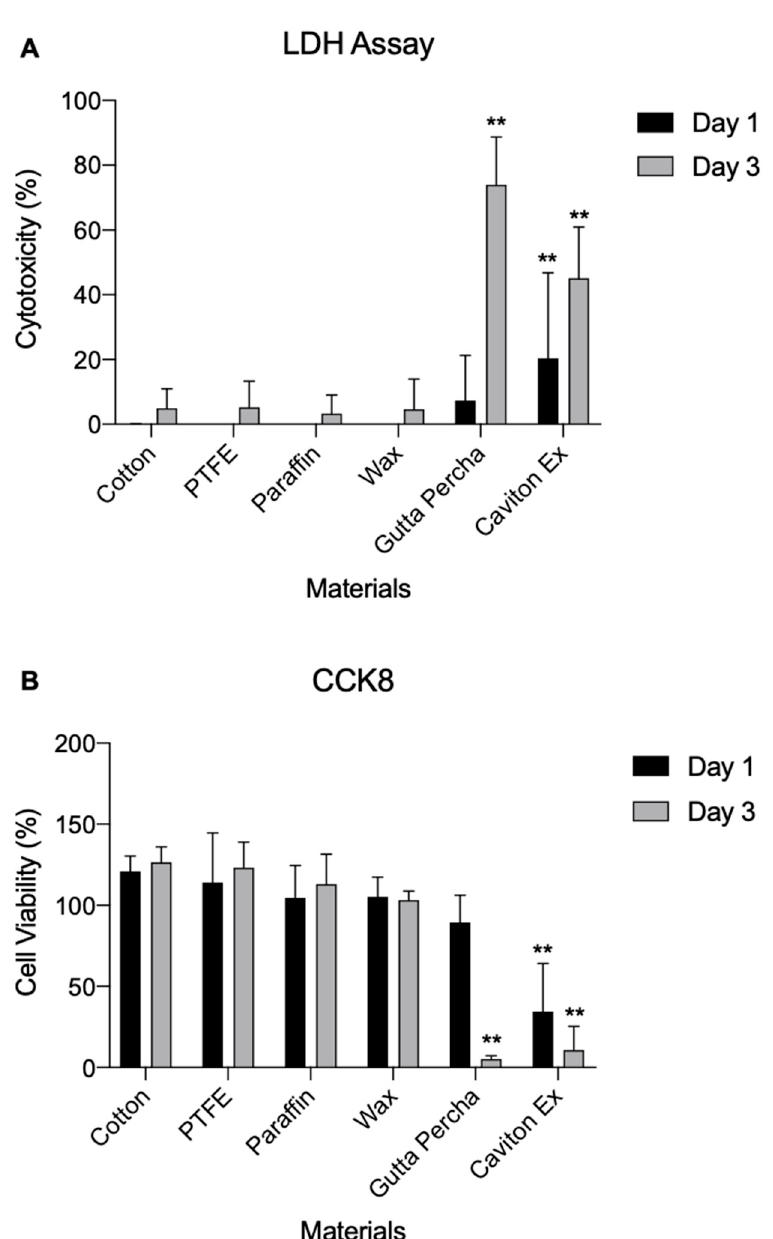
Figure 5. GE-1 cells cytotoxicity test. ( A ) Lactate dehydrogenase assay of the materials against GE-1 cells. The cells were incubated with the materials for 24 and 72 h. ( B ) Cell counting kit 8 assay of the materials. GE-1 cells were cultured for 24 and 72 h. Data are expressed as mean ± standard deviation ( n = 10; ** p < 0.01 vs. cotton group).